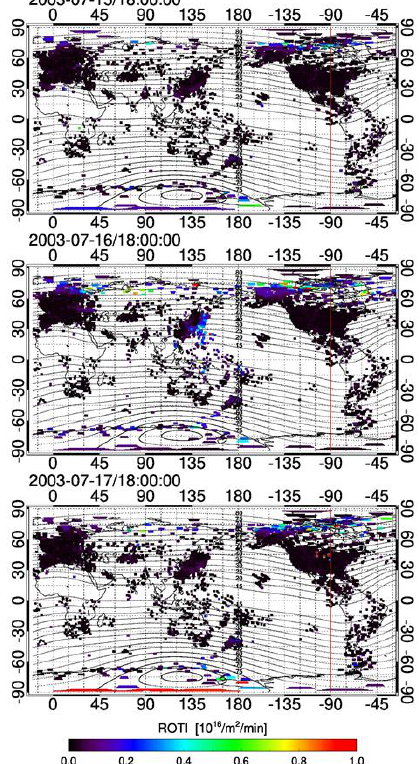
Figure 1. Two-dimensional global maps of ROTI indices in geographic coordinates at 18 UT on ( top ) 15, ( middle ) 16, and ( bottom ) 17 July 2003, as calculated from GNSS receivers (https://stdb2.isee.nagoya-u.ac.jp/GPS/GPS-TEC/ (accessed on 20 January 2023)). The color indicates the ROTI value within a range from 0.0 to 1.0. The red vertical lines represent 12 LT. The contours represent the geomagnetic latitude.